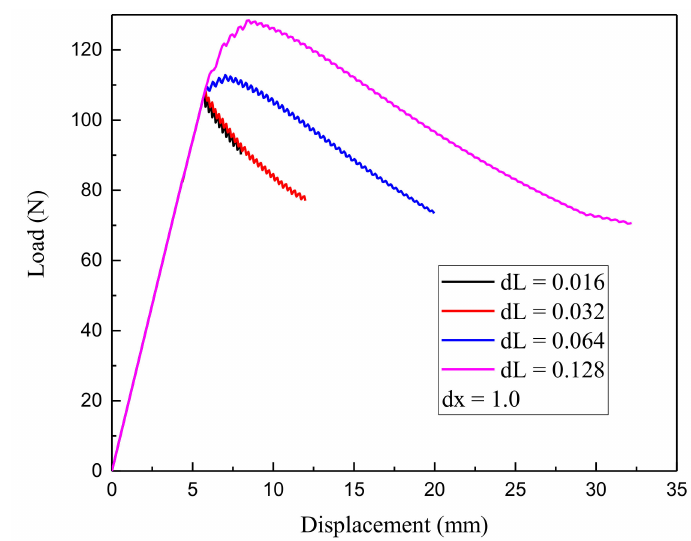
Figure 7. Convergence analysis of loading increment dL for grid spacing dx = 1.0 mm, PD modeling load–displacement.